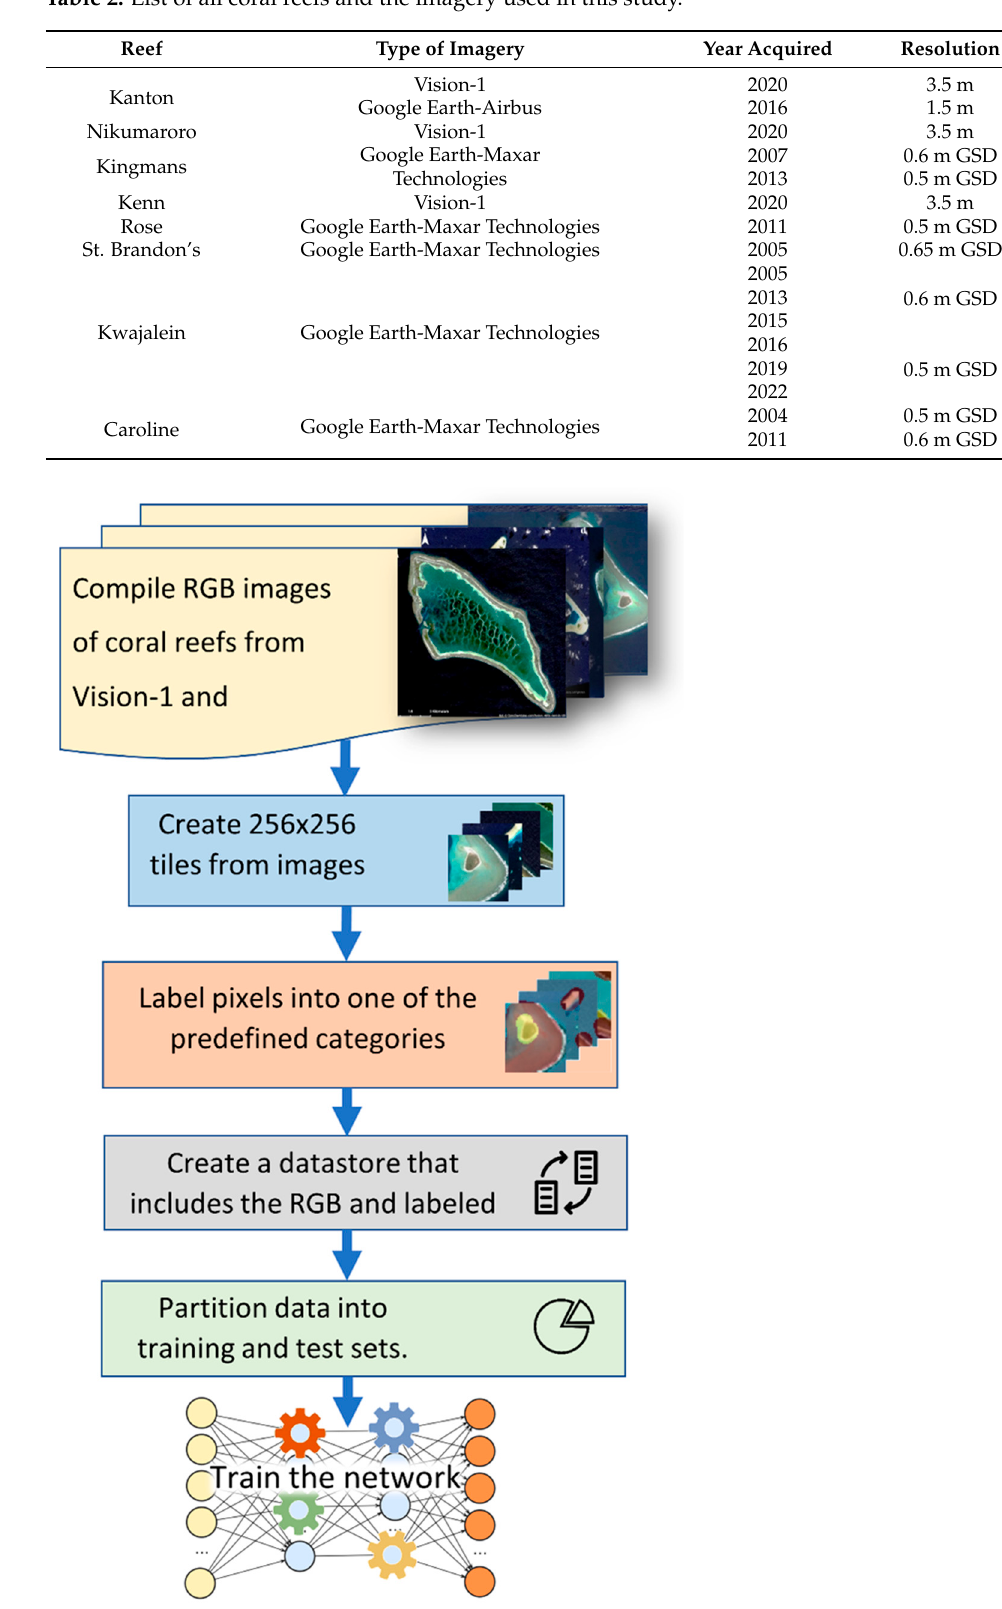
Table 2. List of all coral reefs and the imagery used in this study.